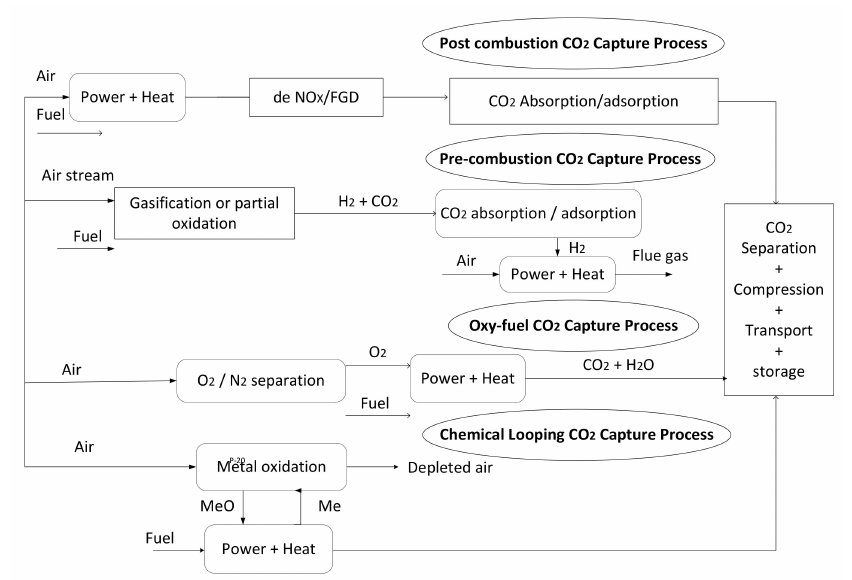
Figure 1. CO 2 capture technologies